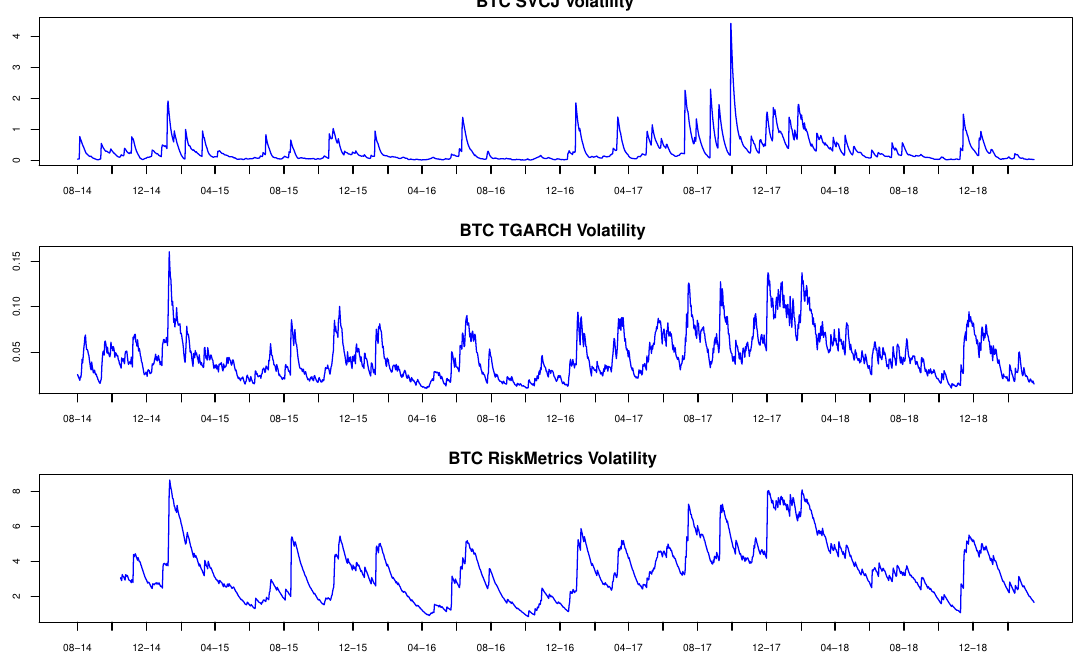
Figure 2. Estimated Volatility from SVCJ, TGARCH, and RiskMetrics